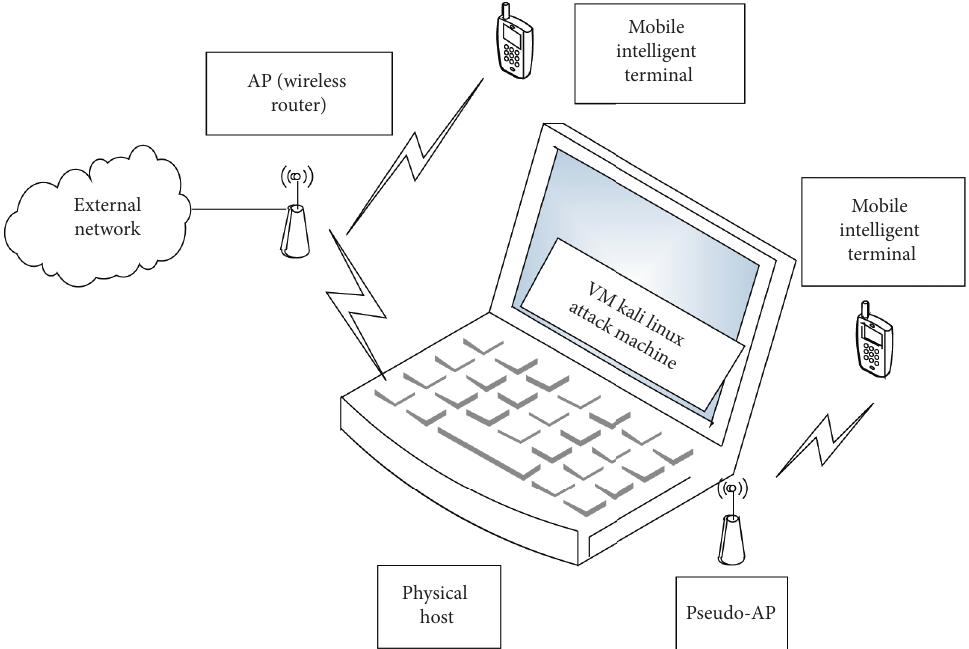
Figure 4: Experimental network topology.